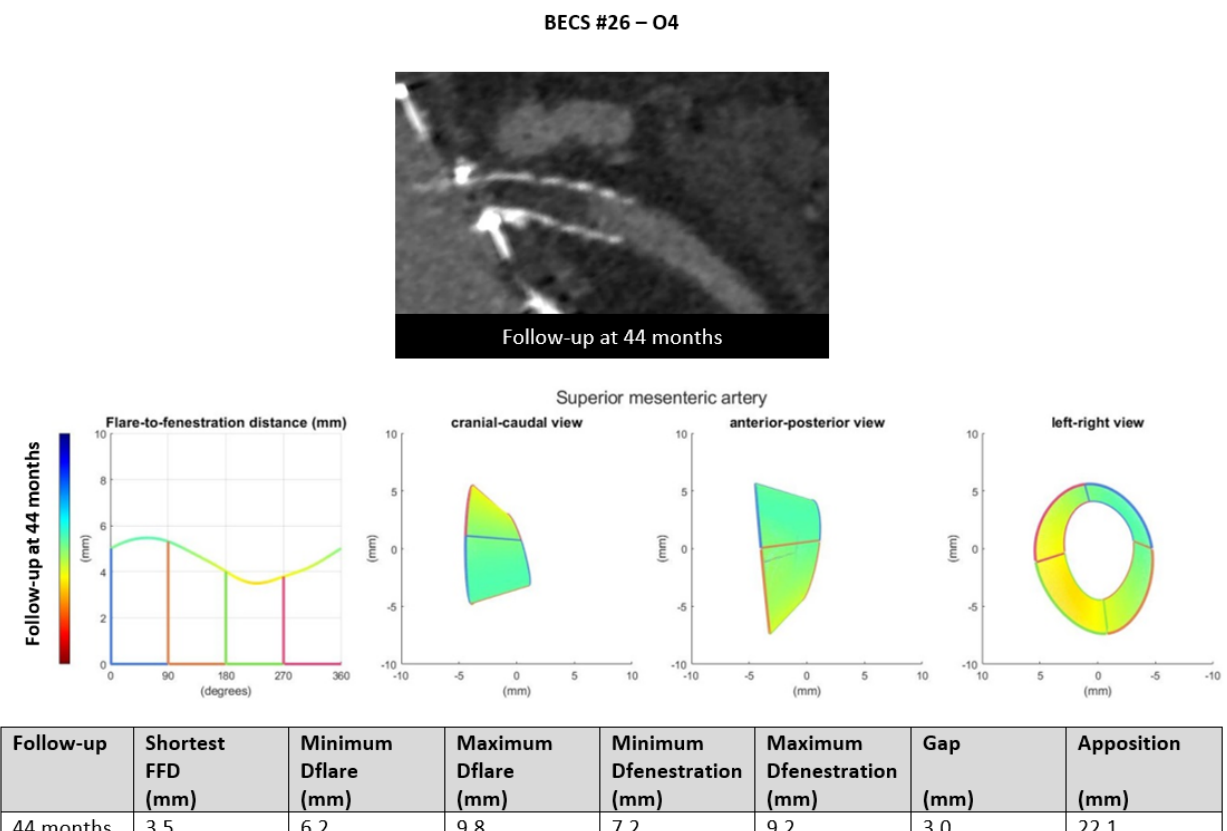
Figure 10. BECS #26 is an example of O4, obstruction without a geometrical cause. The 44 ‐ month post ‐ FEVAR CTA scan reported an occluded BECS. Geometric analysis showed no abnormalities of the BECS geometry that may have caused the occlusion.